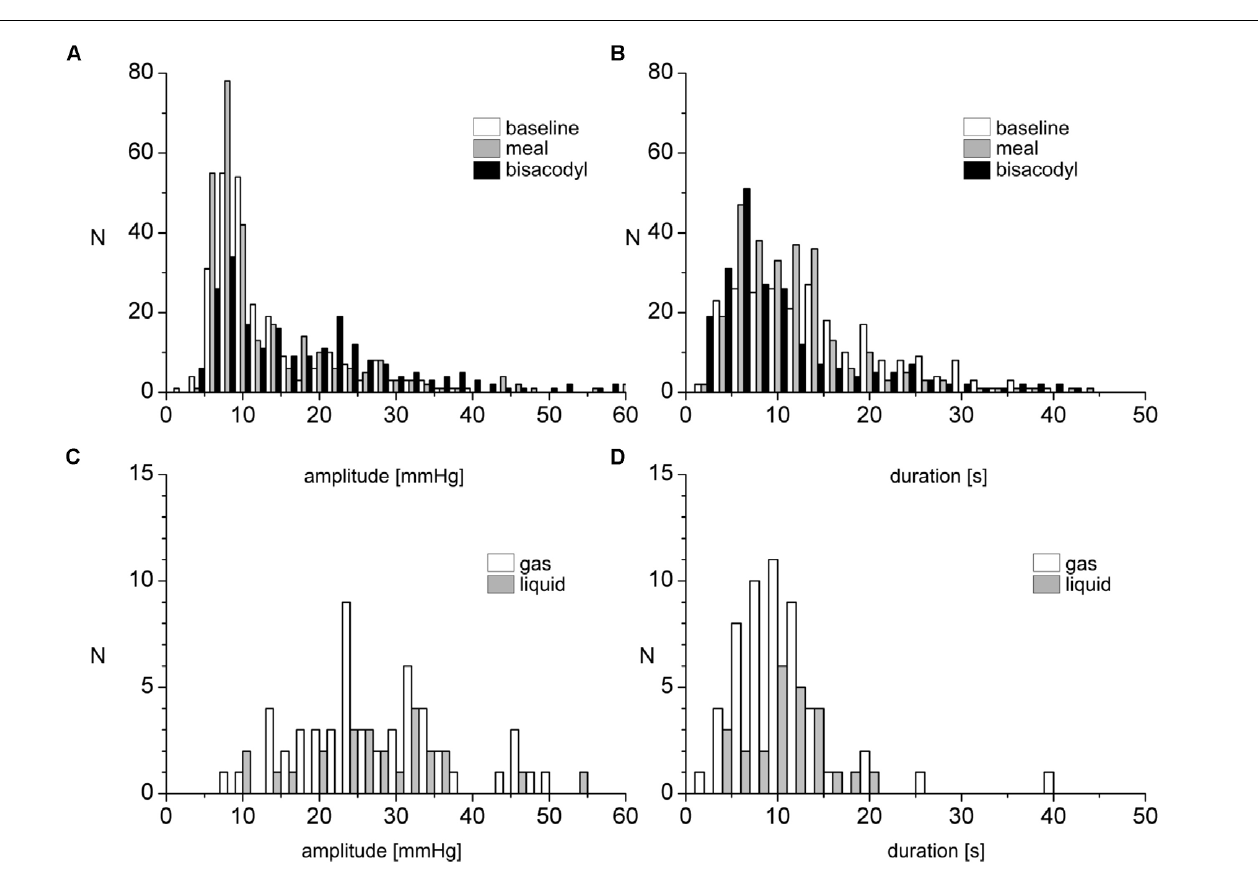
FIGURE 3 | Amplitude and duration distribution of SPWs and their relationship to gas or liquid expulsion. (A,B) Number of occurrences of SPWs, binned according to amplitudes (A) or duration (B) , observed in 17 subjects, before and after a meal and in response to bisacodyl. (C,D) Number of occurrences of SPW amplitudes (C) and durations (D) for SPWs associated with gas or liquid expulsion under all